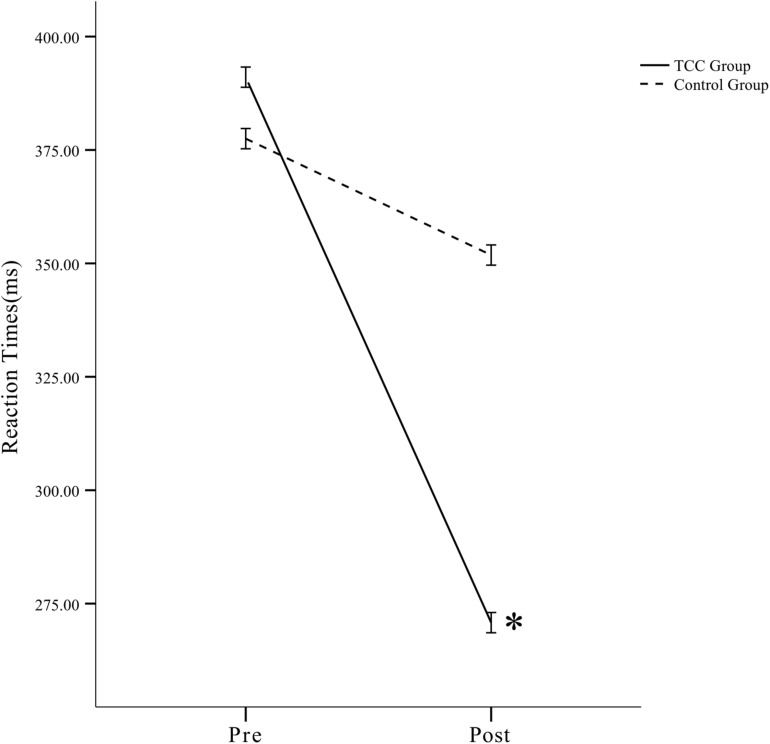
The RTs of the TCC and control groups in the incongruent task were lower than those before the intervention, whereas the reduction in the TCC group was significantly different. ∗p < 0.05, significant difference; Bars indicate standard errors.